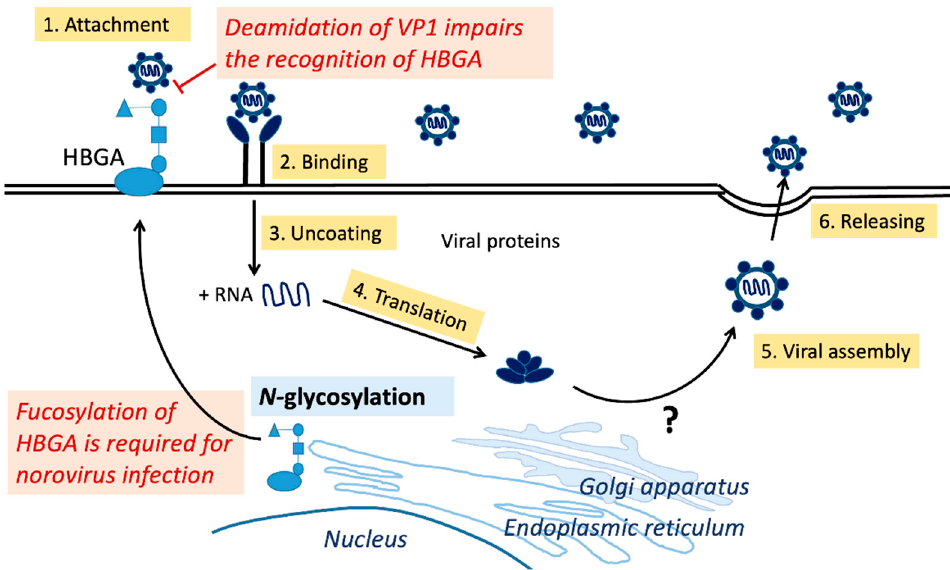
Figure 1. Replication cycle of noroviruses and protein post-translational modifications. (1) Attach- ment: Human norovirus (HuNoV) attaches to the HBGAs on the host cell surface, allowing viral entrance. Note that fucosylation of HBGA by fucosyltransferase 2 (FUT2) is required for certain genotypes of norovirus infection. In contrast, deamination on Asn373 of norovirus capsid protein VP1 impairs the recognition of HBGAs. (2) Binding. (3) Uncoating through undefined pathways [80]. (4) Translation: The positive-sense RNA genome may serve as a template for viral protein translation. After translation, viral proteins could undergo N - or O -glycosylation at the endoplasmic re- ticulum or Golgi apparatus. Mechanisms of noroviral protein glycosylation remain unclear. (5) As- sembly: viral proteins assemble to form new viral particles. (6) Release: viral particle release from host cell [81]. Abbreviations: HBGA, histo-blood group antigen.